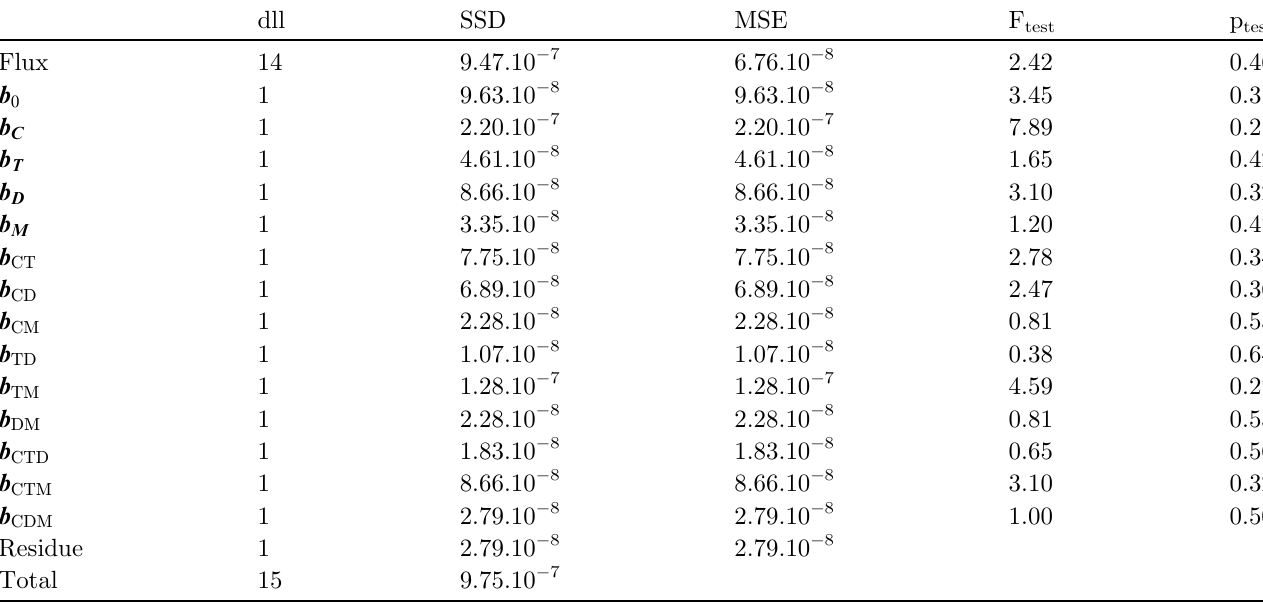
Table 6. Statistical study of the presented polynomial model of fl ux during desorption.